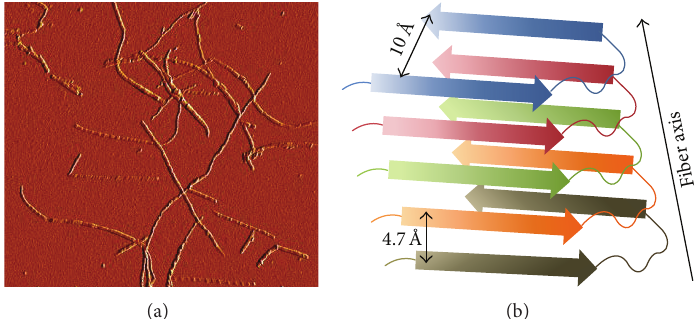
Figure2:(a)Representativetappingmodeatomicforcemicroscopyimage(amplitudemode)ofIAPPamyloidfibrilspreparedinhomogenous solution (50 𝜇 M at 37 ∘ C for 24 h.). (b) Schematic representation of the general cross- 𝛽 -sheet quaternary structure of amyloids showing the interstrand ( ≅ 4.7 ˚A) and intersheet ( ≅ 10 ˚A)